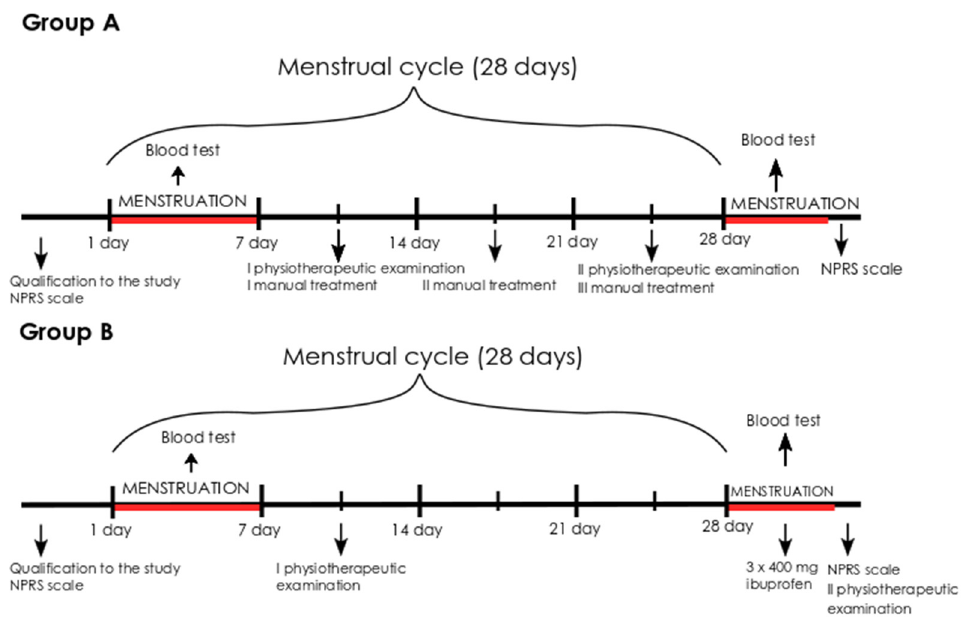
Figure 2. The scheme for carrying out therapy in groups A and B. Modified figure from previous publication [22].